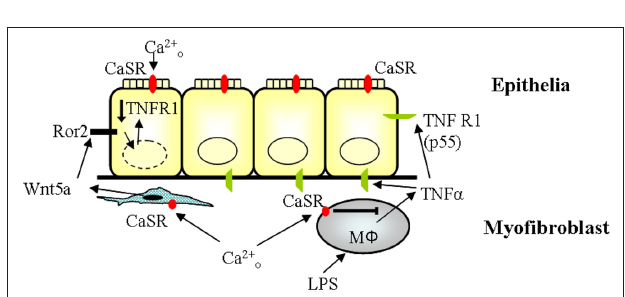
FiguRe 7 | Multi-cell role of CaSR on TNF signaling. TNFR1 signaling is inhibited by CaSR through two mechanisms. CaSR increases the secretion of wnt5a from the myofibroblasts, which interacts with Ror2 and leads to a decrease in TNFR1 expression. CaSR also inhibits the secretion of TNF α from macrophages, thereby interrupting TNFR1